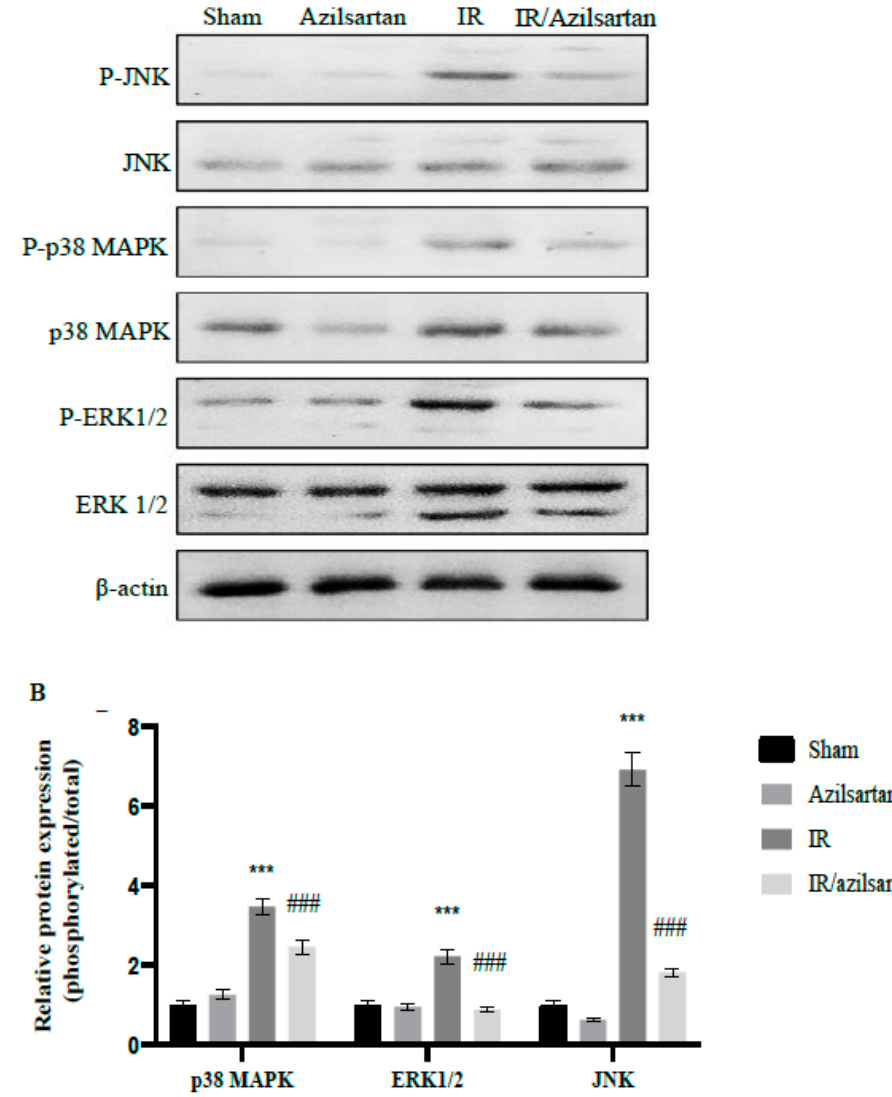
Figure 4. Effect of azilsartan on the expression of p38 MAPK, ERK1/2, and JNK proteins. ( A ) Representative Western blots of phosphorylated and total p38 MAPK, ERK1/2, JNK, and β -actin proteins for different groups. ( B ) Expressions of phosphorylated/total ratio of proteins were densitometrically expressed as fold change, using bands in ( A ), relative to that of sham control rats, after normalization to the corresponding β -actin. Bars represent mean ± SD. Followed by post hoc Dunnett test, significant difference was analyzed by two-way ANOVA test, where ***; p < 0.001, compared to the sham group, and ### p < 0.001, compared to the IR group. p38 MAPK; Mitogen Activated Protein Kinase, ERK1/2; extracellular signal-regulated protein kinase, c-JNK; Jun N terminal kinase, SD; standard deviation, IR; ischemia reperfusion.